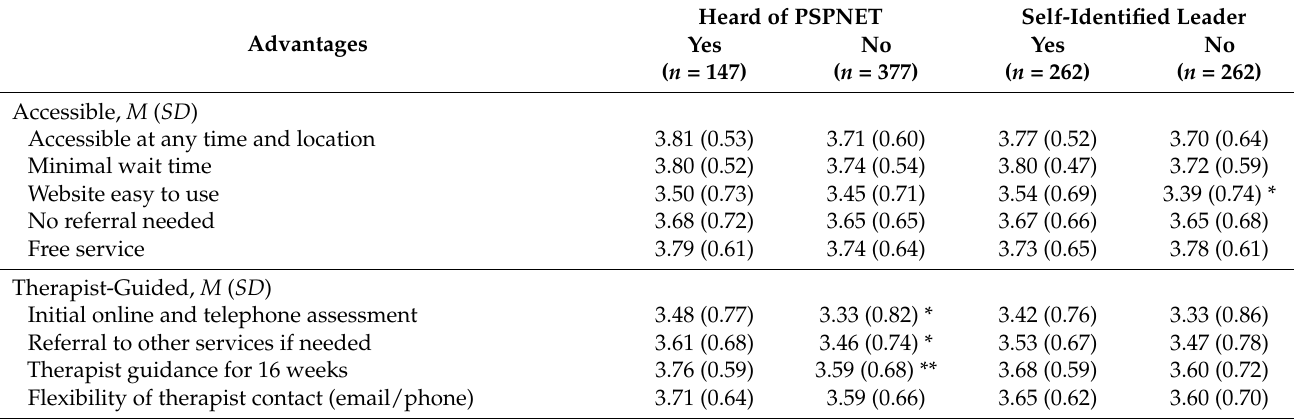
Table 3 for a summary of the findings. Table 3. Perceived advantages of